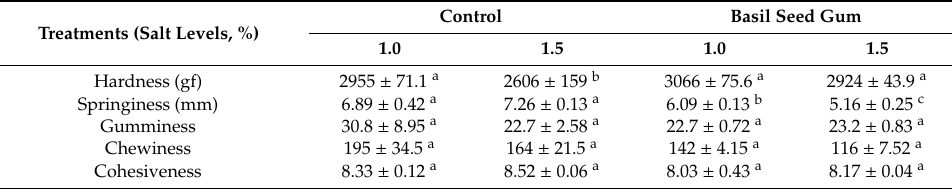
Table 7. Textural properties of low-fat sausages with basil seed gum at di ff erent salt levels. Treatments (Salt Levels, %)